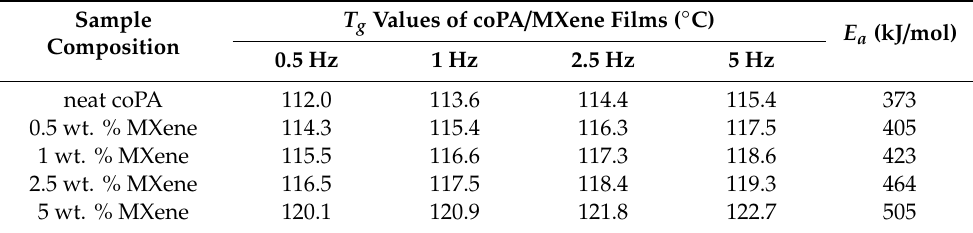
Table 2. The calculated activation energies for various composite thin